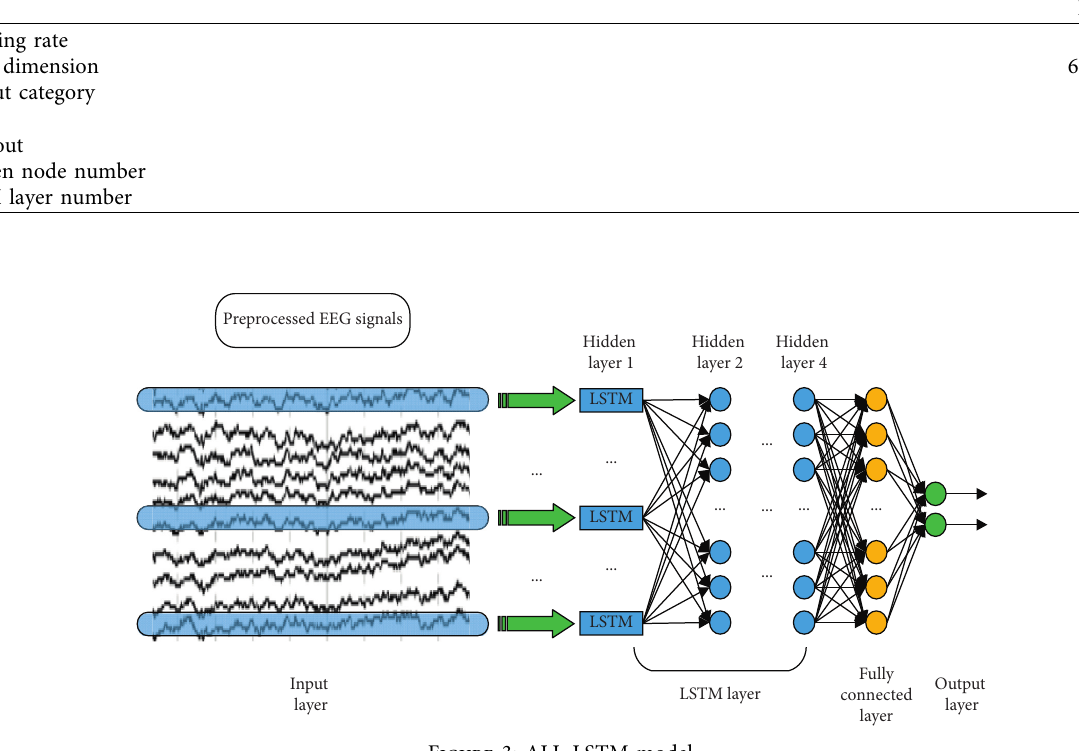
Figure 3: ALL-LSTM model.